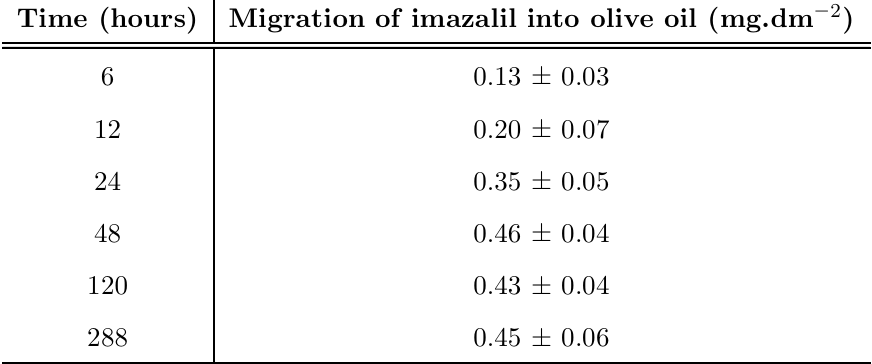
Table 2 Migration of Imazalil from polyethylene › lm at 25 o